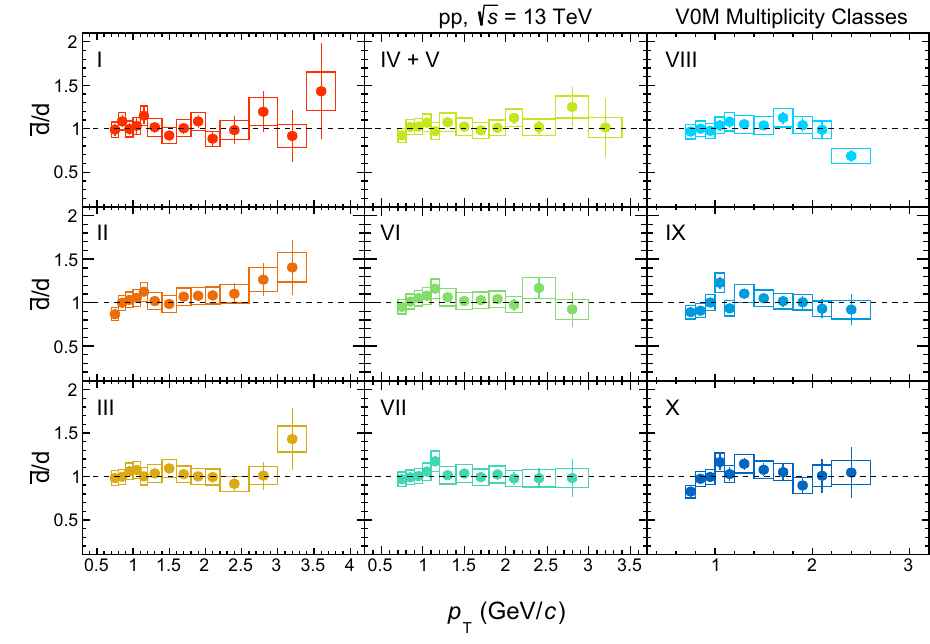
Fig. 2 Ratio between the transverse momentum spectra of anti-deuterons and deuterons in different multiplicity classes. The statistical uncertainties are represented by vertical bars while the systematic uncertainties are represented by